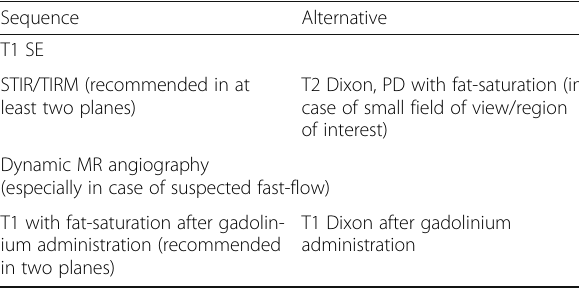
Table 4 Example of MR imaging protocol Sequence